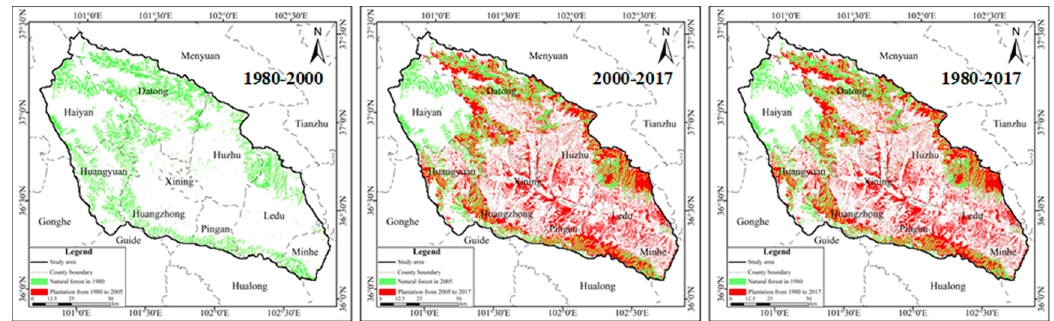
Figure 9. Scale of the coupled slope ecological restoration and natural forest in different periods (the red is the slope ecological restoration and the green is the natural forest).